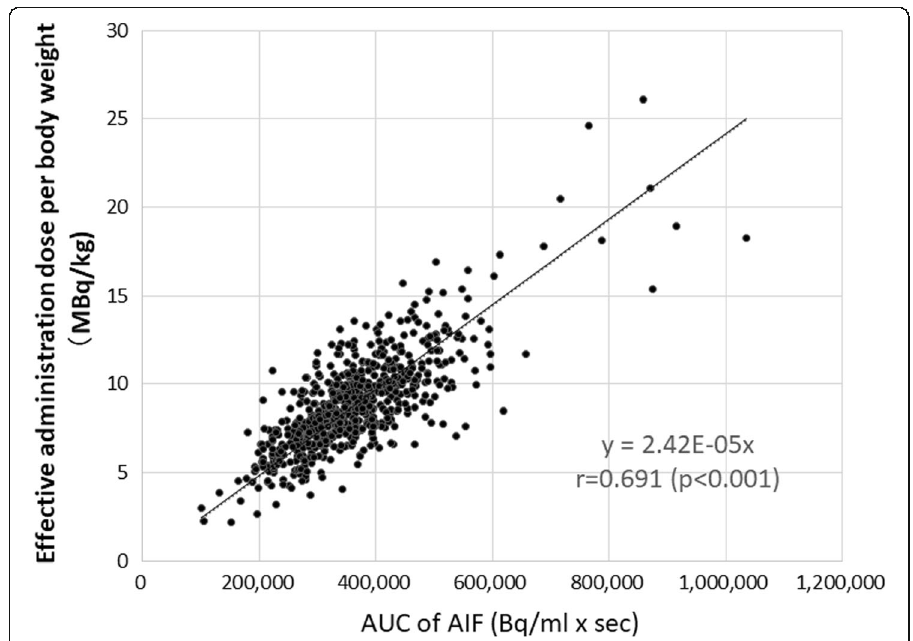
Fig. 7 Effective C 15 O 2 administration dose per body weight as a function of the area-under the curve (AUC) of the calibrated arterial input function